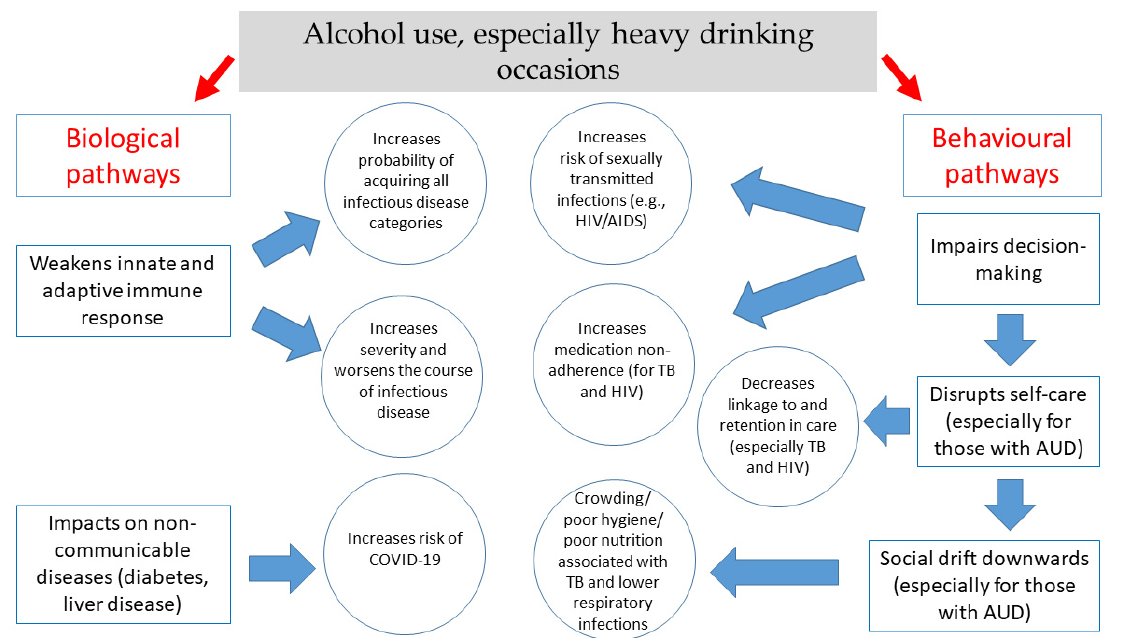
Figure 1. Key biological and behavioral mechanisms through which alcohol use is associated with communicable diseases. There has been limited research that has identified effective interventions for address- ing alcohol-attributable TB and pneumonia, suggesting an urgent need for research in these areas, while several effective interventions to address alcohol-attributable HIV infection have been determined. Implementation of effective individual-level interventions, as well as alcohol control measures as a means of reducing the burden of communicable diseases, are recommended.